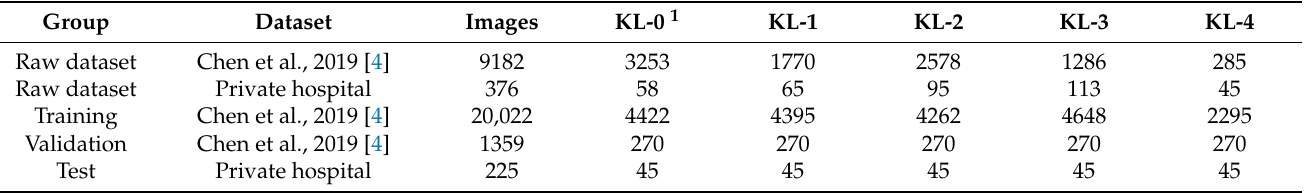
Table 1. Description of the raw dataset and the processed dataset. The numbers in the tables indicate the number of knee images used in each